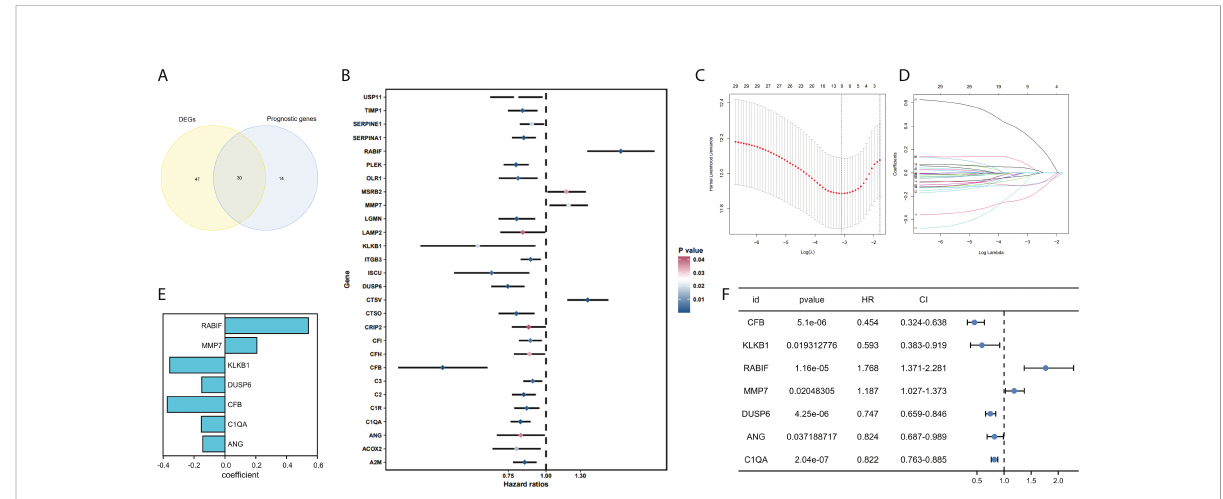
FIGURE 2 Development and validation of coagulation-related genes predictive signature. (A) Intersection of DEGs and Prognostic genes depicted via Venn diagram. (B) Univariate Cox regression analysis of predictive DEGs related to SKCM survival presented as a forest map. (C) LASSO regression of 9 coagulation-related genes. (D) Cross-validation for tweaking the parameter in the LASSO regression. (E) The corresponding coef fi cients for 7 candidate genes. (F) Univariate Cox regression analysis of 7 candidate genes related to SKCM survival presented as a forest